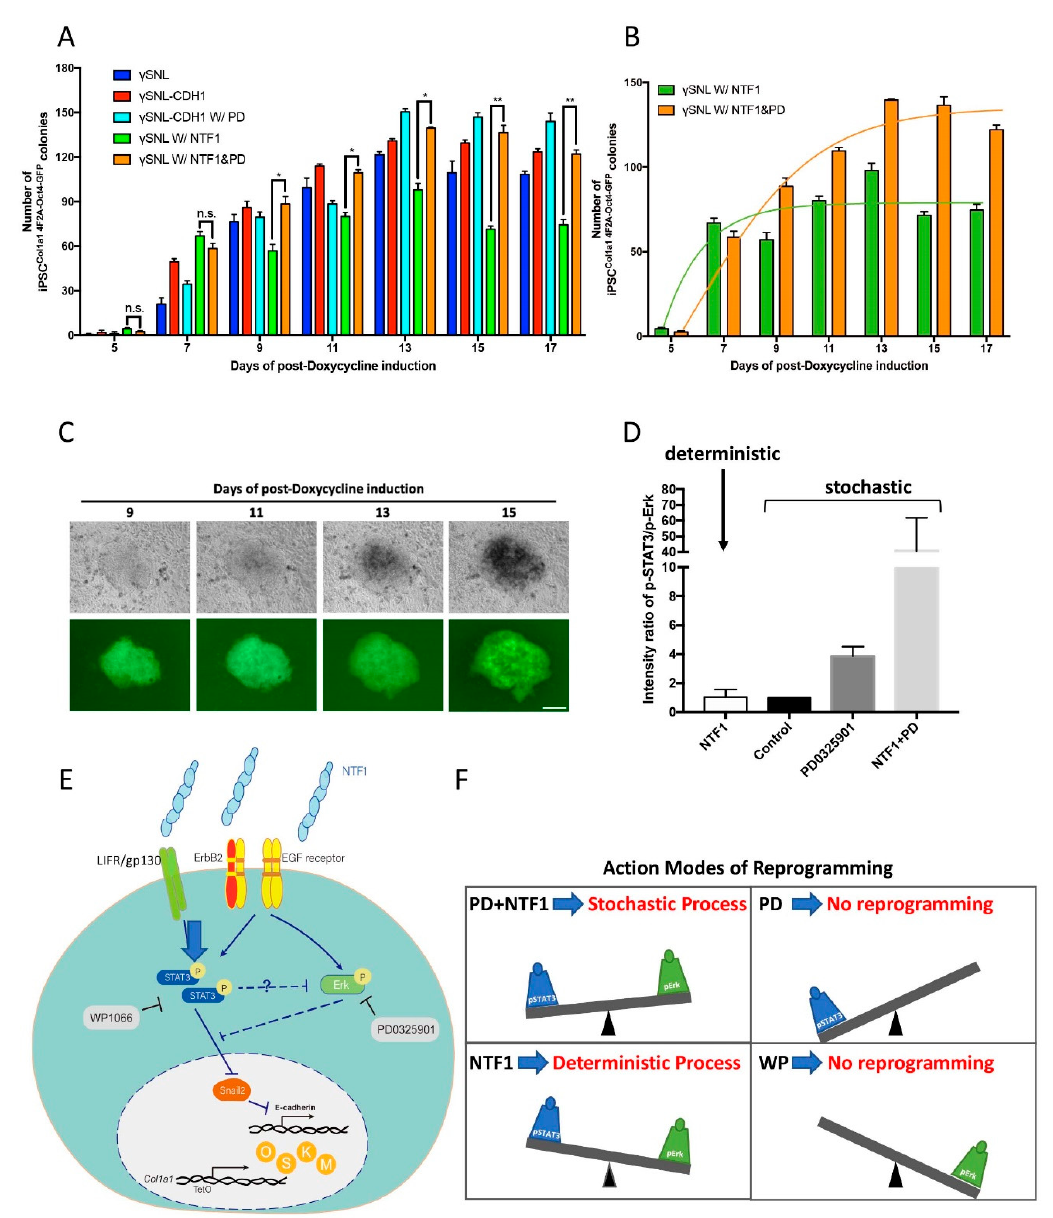
Figure 5. The differential effects of NTF1 and PD0325901 on the choice of programming process at the onset of iPSC induction ( A ) The quantitative analysis of iPSC colony formation under various treatments. The number of the OCT4-GFP-positive clones is indistinguishable between MEF cells treated with NTF1+PD0325901 and those treated with NTF1 alone on the 7th day postdoxycycline induction. However, the NTF1 alone condition maintained the OCT4-GFP-positive clone number observed on the 7th day throughout the entire course of induction (green bar). In contrast, the NTF1+PD0325901-treated group showed an increase the OCT4-GFP-positive clone number until the end of induction (orange bar). ( B ) The curve-fitting data of the NTF1 (green) and NTF1+PD (orange) groups extracted from panel A. The NTF1-treated group (green) represents the deterministic process, whereas the NTF1+PD group (orange) shows the stochastic model. ( C ) Rep- resentative time-lapse photographs of iPSC Col1a1 4F2A Oct4-GFP clone formation induced by NTF1+PD0325901. The series of photographs was obtained from the same clone from the 9th to 15th day postdoxycycline induction. The scale bar denotes 50 µm. ( D ) The selection of a reprogramming process depends on the pSTAT3 vs. pErk1/2 ratio. In the presence of NTF1, the pSTAT3/pErk1/2 ratio creates a unique cell state and a threshold where it engages the deterministic process during reprogramming. If the ratio is higher than the NTF1-established ratio, reprogramming will occur through the stochastic route instead. ( E ) A proposed mechanism addresses the selection of the somatic reprogramming mode. The current model